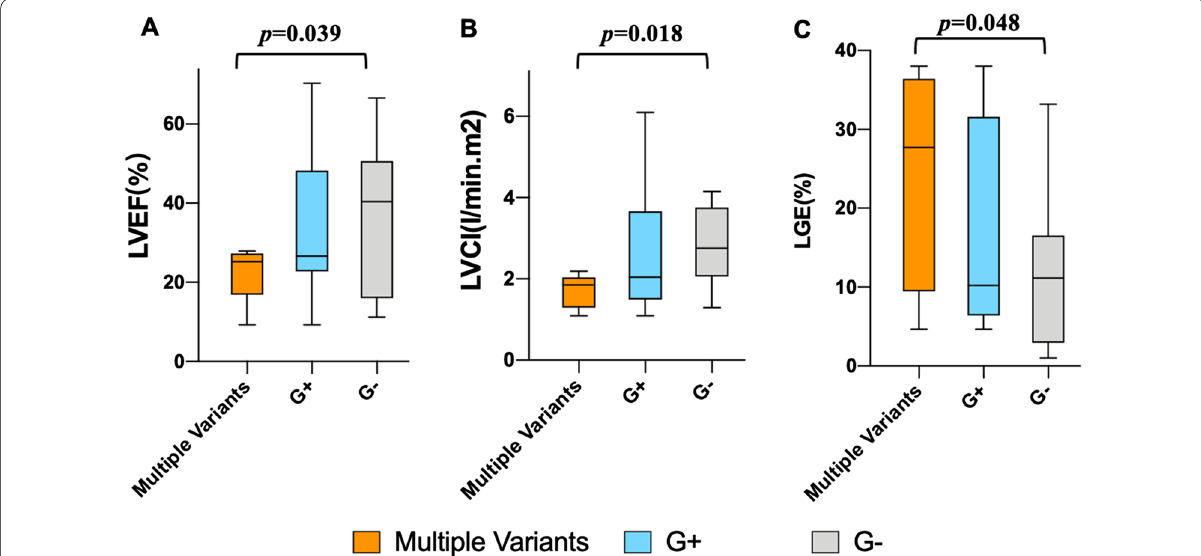
Fig. 2 Correlations among carriers of multiple variants, G Mann–Whitney U-test between parameters from carriers of multiple variants and G